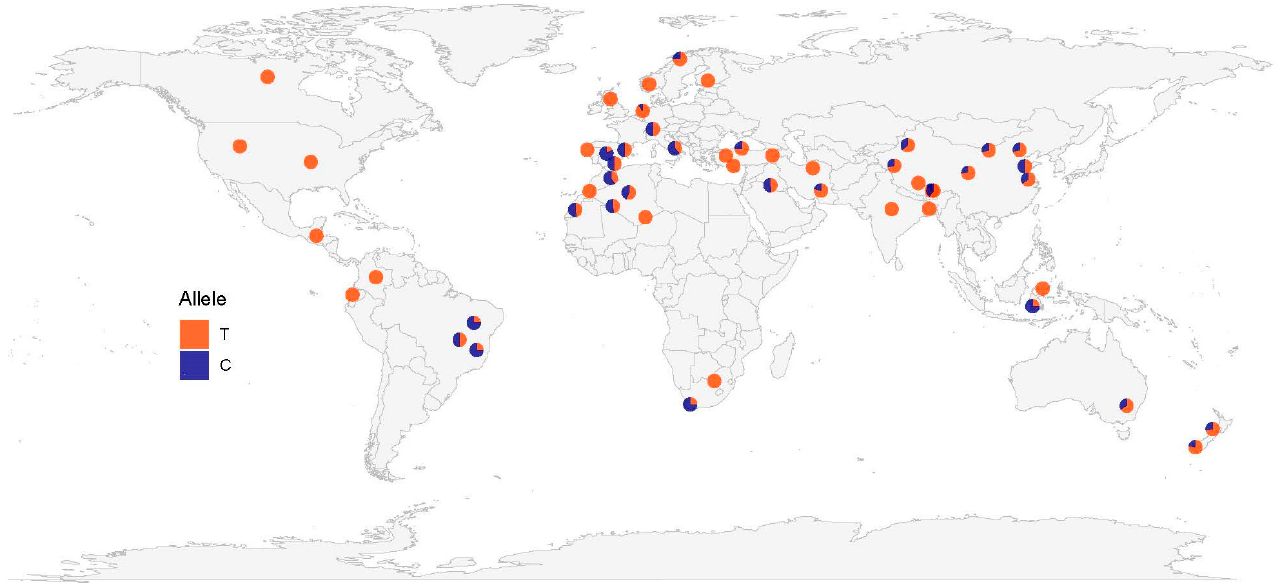
Figure 3. Allele frequency distribution of the variation c.352+1232T>C in the BMP15 gene.